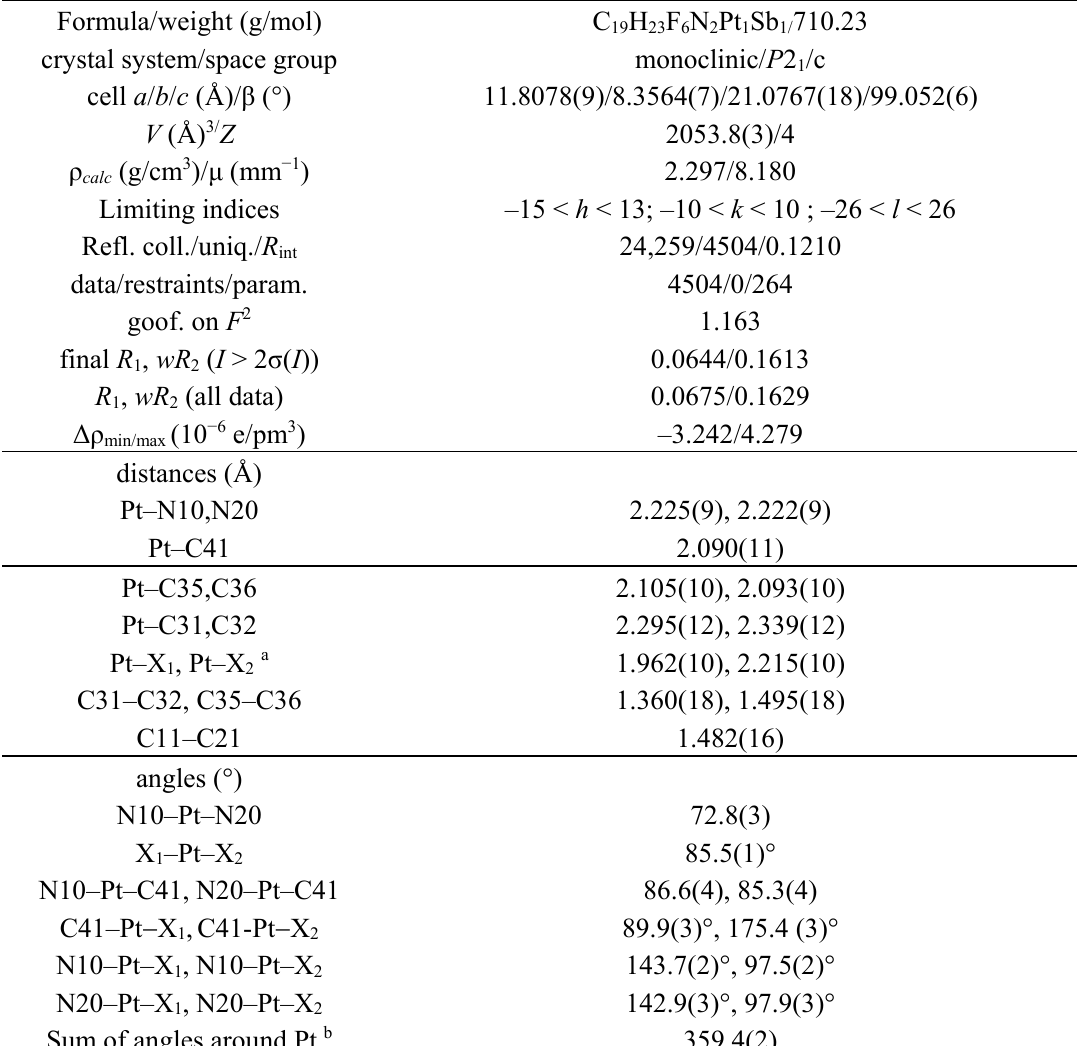
Table 1. Details of the crystal structure determination and selected structural data